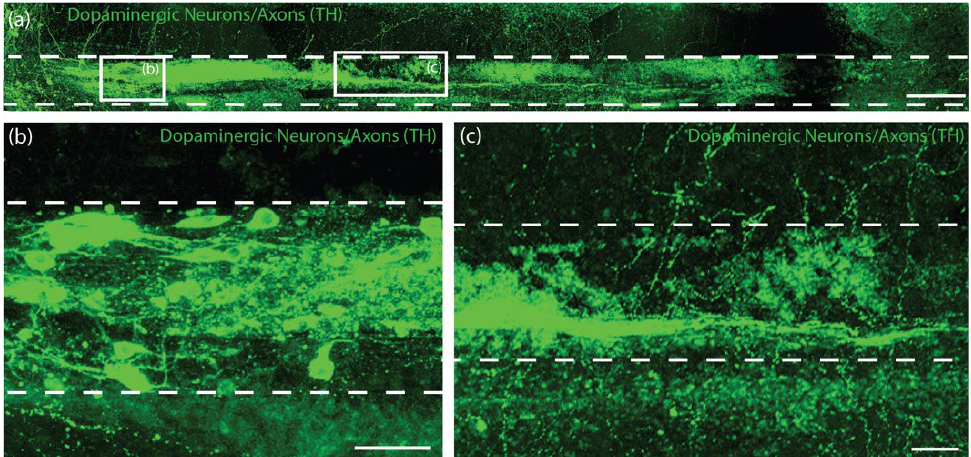
Figure 8. TE-NSP neuronal survival at 1-week post-implant. ( a ) Representative confocal reconstruction of an enriched TE-NSP 1-week post-implant labeled via immunohistochemistry to denote dopaminergic neurons/axons (TH, green). The TE-NSPs maintained their cytoarchitecture consisting of distinct cell body and neurite regions, with dopaminergic neurites projecting longitudinally within the micro-column. Higher magnification reconstructions from demonstrative regions in ( a ) depict the ( b ) dopaminergic neuron aggregate and ( c ) robust, aligned TH+ axons. At 1-week in vivo, neuronal survival was found within all of the transplanted TE-NSPs; however, no evidence of neuronal survival was found within the other transplant groups (solitary aggregates transplanted into the SNpc or striatum). Scale bar ( a ) = 250 µm. Scale bar ( b , c ) = 50 µm.